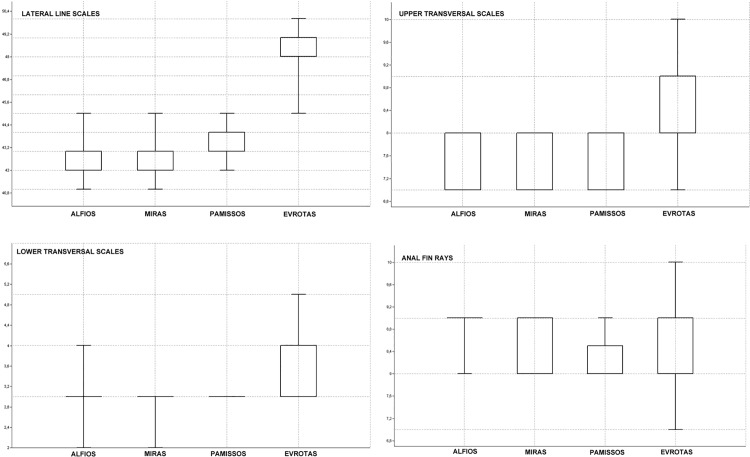
Box-plot of meristic variables.The 25–75 percent quartiles are drawn inside the box. Short horizontal lines represent minimal and maximal values.